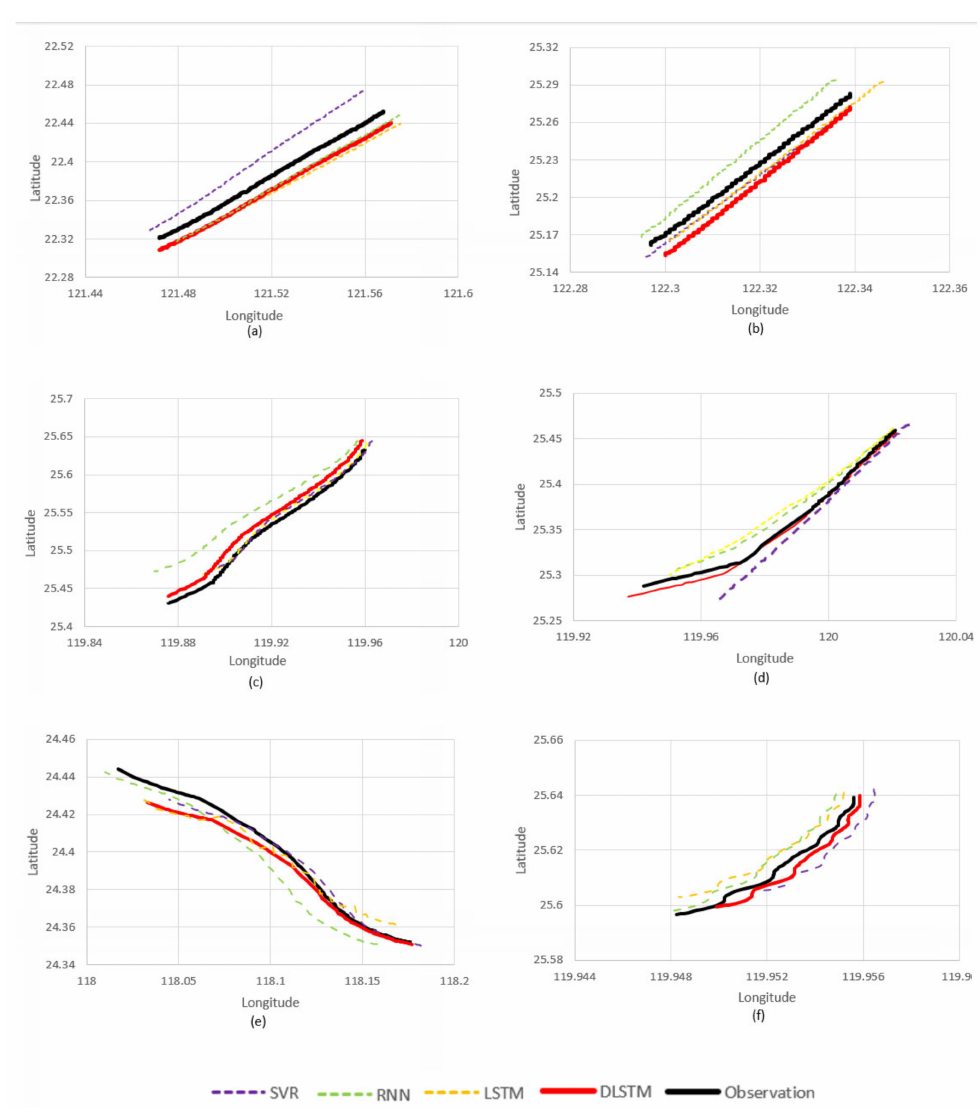
Figure 11. Vessel trajectory predicted result using 4 models. ( a ) 477147900; ( b ) 215280000; ( c ) 477118100; ( d ) 413484000; ( e ) 413697130; ( f )